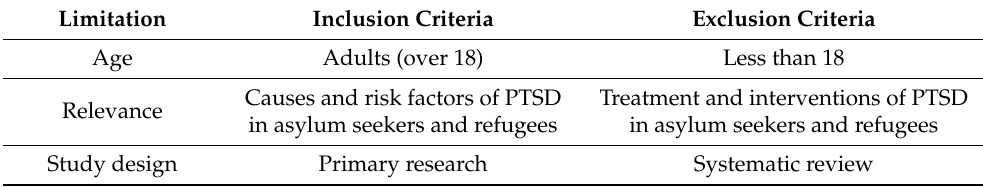
Table 1. Inclusion and exclusion